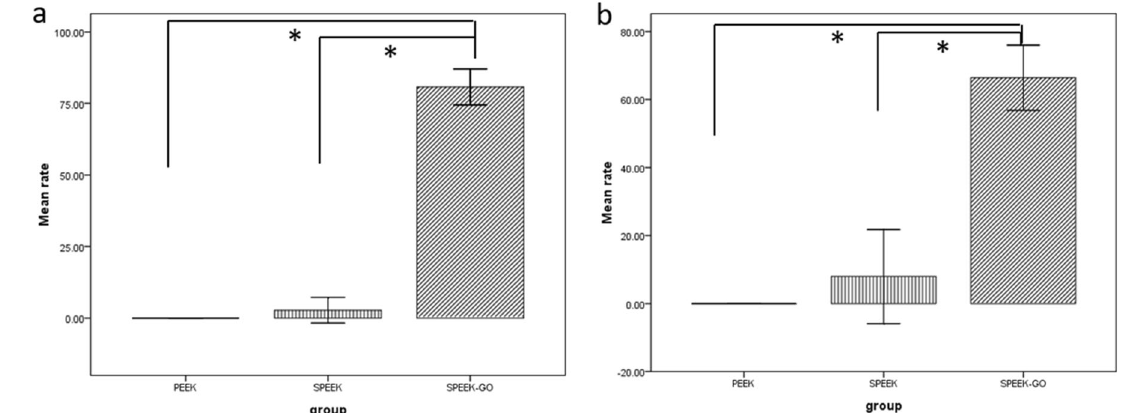
Fig. 8 Results of rates of antibacterial activity of PEEK, SPEEK, and SPEEK-GO against P. gingivalis ( a ) and S. mutans ( b ). The SPEEK- GO bactericidal rate of P. gingivalis was 80.75% ± 2.54% and S.